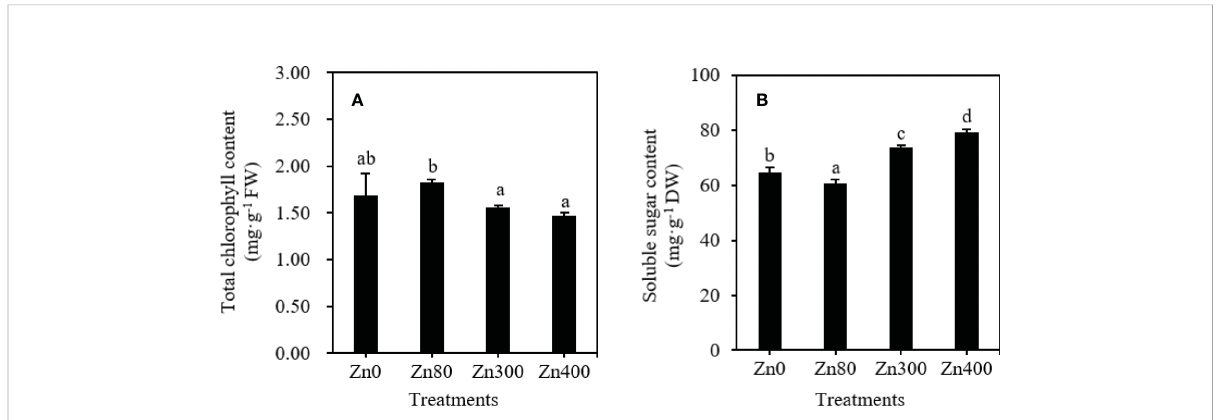
FIGURE 2 The contents of total chlorophyll (A) , soluble sugar (B) in leaves of Cd-contaminated K. obovata under different concentration of Zn treatments. The data are shown as the means ± SD